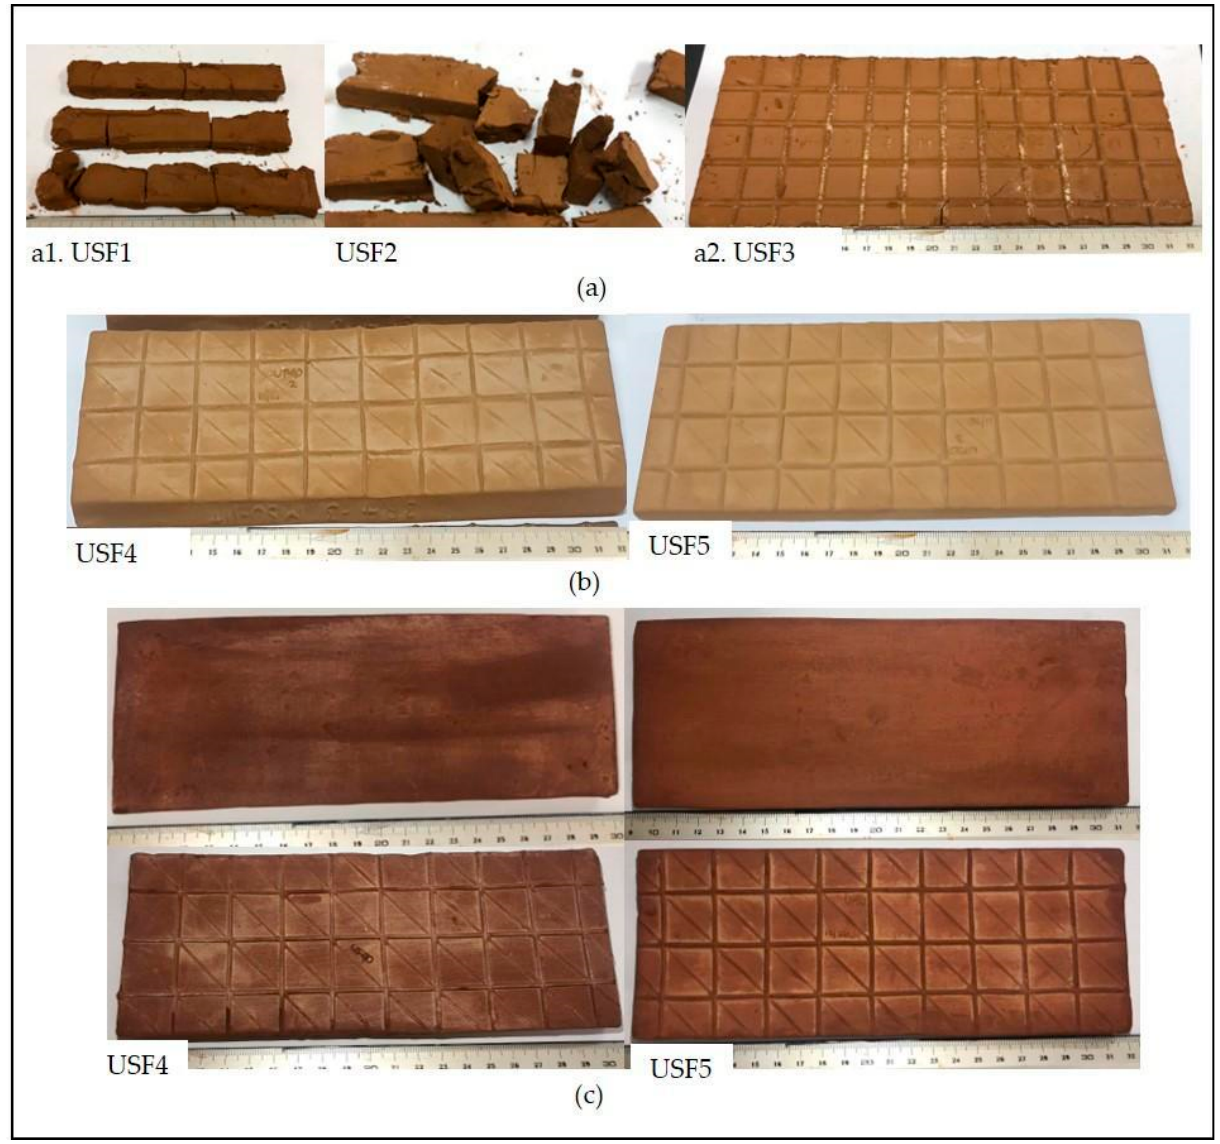
Figure 7. Tiles from NMW slip. ( a ) Failed casting using USF1, USF2 and USF3; ( b ) successful casting of tiles using USF4 and USF5; and ( c ) USF4 and USF5 tiles fired at 1050 °C.